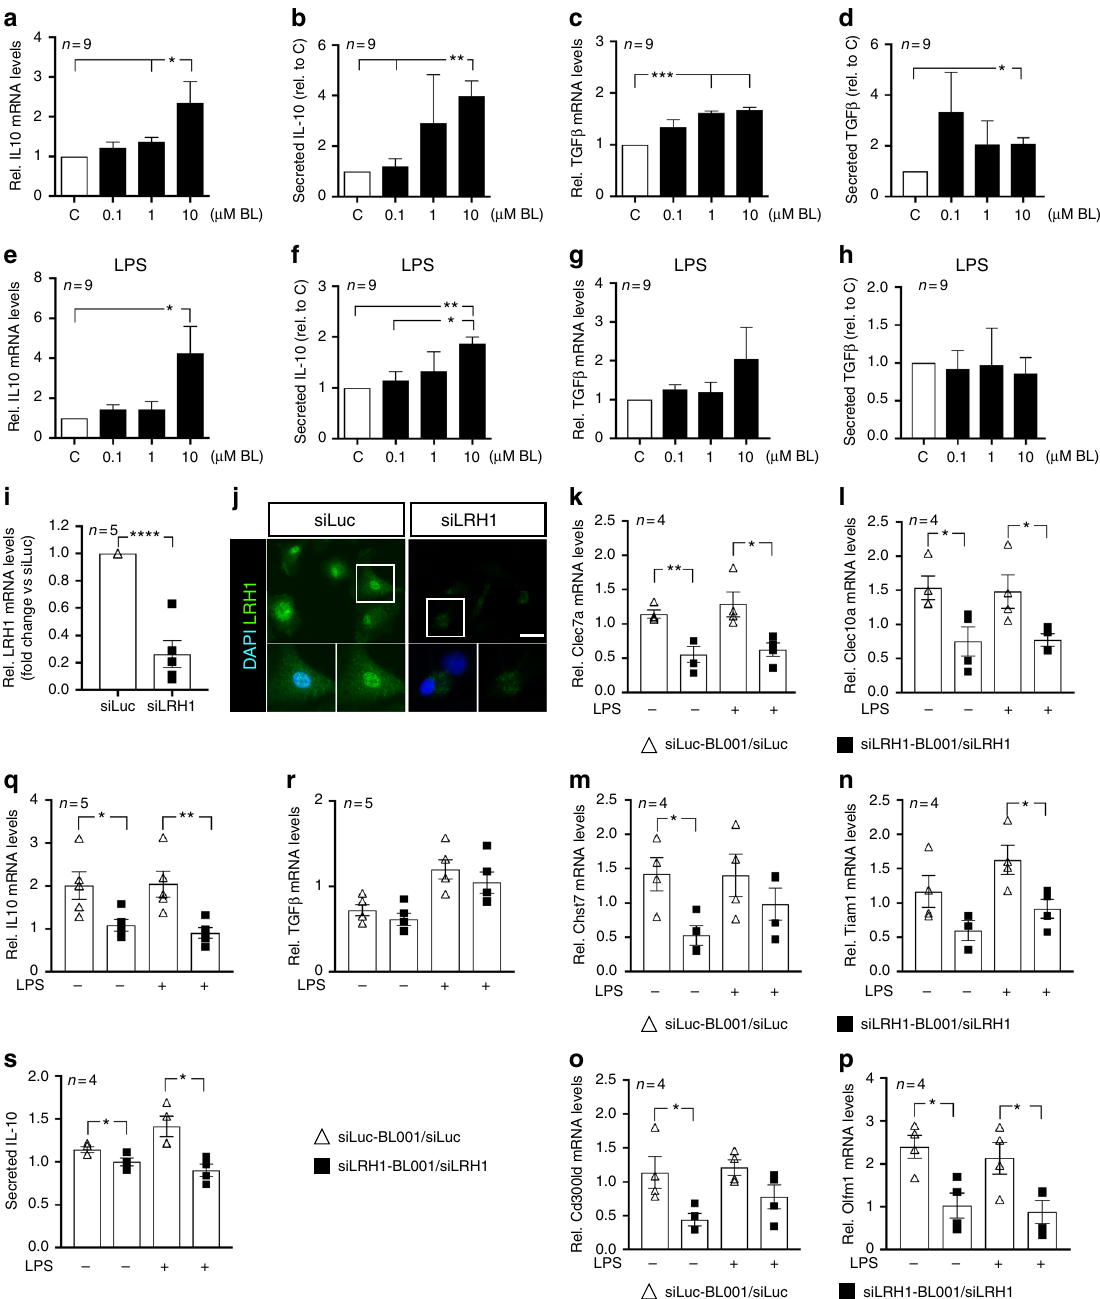
Fig. 4 LRH-1 is required for BL001-mediated M2 polarization. Primary macrophages were exposed in culture to increasing concentration of BL001 for 24 h. Media was collected and RNA isolated to perform QT-PCR. Transcript and secreted levels of a , b Il10 and c , d Tgfb were then determined ( n = 9 mice). e – h Primary macrophages were incubated for 24 h with increasing concentrations of BL001 alone or in combination with 1.0 µ g/ml lipopolysaccharide (LPS). Transcript and secreted levels of e , f IL10 and g , h TGFbeta were then measured ( n = 9 mice). i siRNA-mediated repression of LRH-1 transcript and j protein levels in mouse primary macrophages as assessed by QT-PCR and immunostaining (LRH-1, green; scale bar: 25 µ M). Relative expression levels of M2 signature genes, k Clec7a , l Clec10a , m Chst7 , n Tiam1 , o Cd300ld , and p Olfm1 in control or LRH-1-silenced macrophages treated or not with 10 µ M BL001 and LPS ( n = 4). q Il10 and r Tgfb transcript levels in siLRH1-treated or not macrophages in the presence or absence of 10 µ M BL001 and LPS ( n = 5). s Secreted levels of IL10 in silenced or not macrophages. Results are expressed as the averages + s.e.m. ( a – i and k – s ). * p < 0.05, ** p < 0.01, *** p < 0.001, and **** p < 0.0001, one-way ANOVA ( a – h ) and Student ’ s t test ( i , k – s